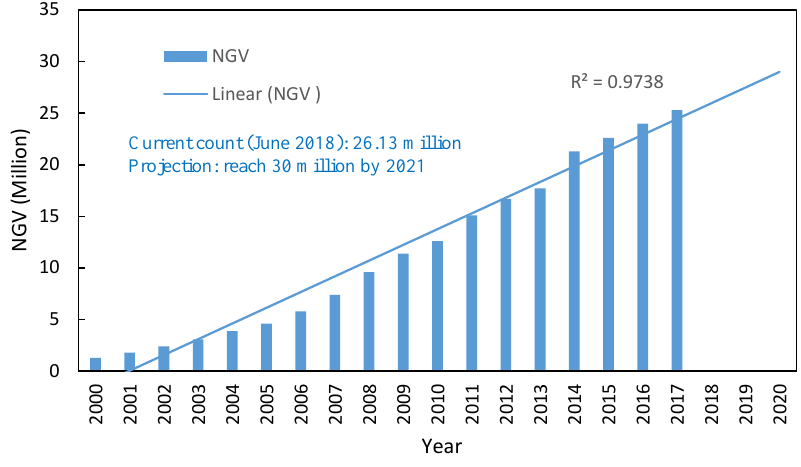
Figure 3. Total worldwide number of natural-gas vehicles from 2000 to June 2018 [78].